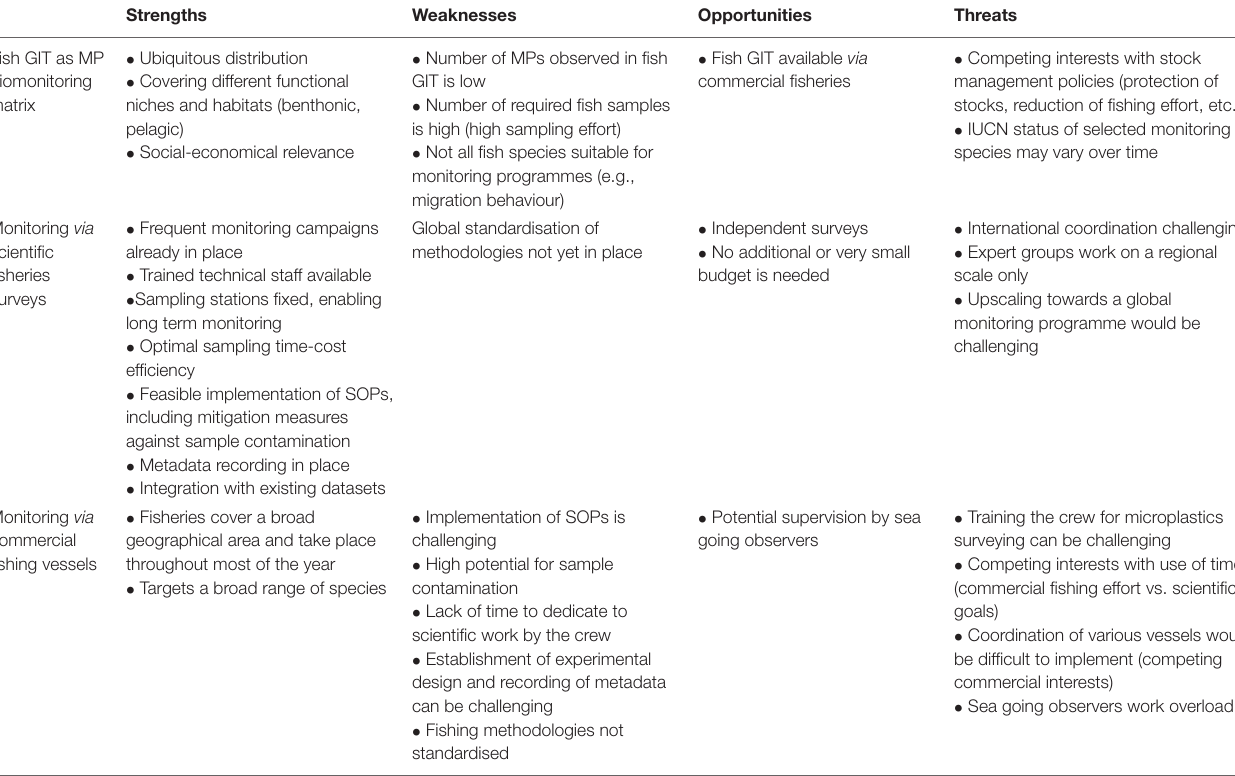
TABLE 7 | SWOT analysis on implementing MP biomonitoring in fish GIT: fish GIT as biomonitoring matrix and sampling platform.